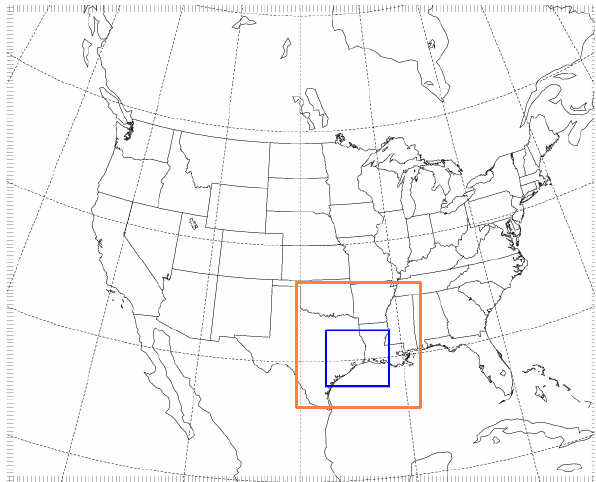
Figure 2. Nesting domain for WRF and MM5 model. The blue box is the 4km domain that all model outputs were extracted